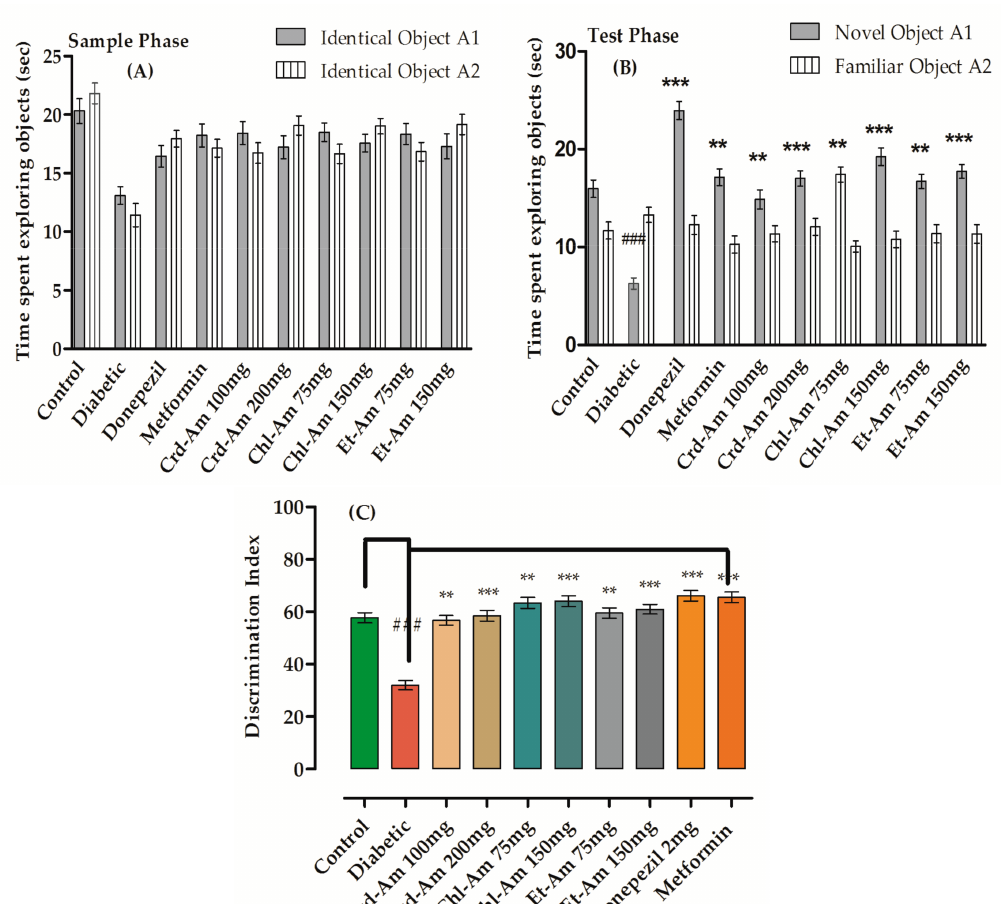
Figure 2. Behavioral results from novel object recognition test (NORT) in long-term memory on crude extract and its fractions of A. macrocephala . Time spent in sample phase is ( A ) and time in test phase is ( B ), while index of % discrimination is ( C ) is noted for crude extract (200 and 100 mg/kg) and fraction (150 and 75 mg/kg)-treated groups versus the STZ-treated diabetic group for the evaluation and recognition of memory in mice models. Mean ± SEM ( n = 6). One-way ANOVA is followed by Dunnett’s post hoc multiple comparison test. ### p < 0.001 comparison of STZ-treated diabetic (amnesic) group vs. normal control, ** p < 0.01 and *** p < 0.001 in comparison with STZ-treated diabetic (amnesic) group vs. Donepezil-, Metformin-, crude extract- and fraction-treated groups, using one-way ANOVA followed by Dunnett’s comparison. Crude extract (Crd-Am), hexane (nhex-Am), chloroform (Chl-Am), ethyl acetate (Et-Am), butanol (But-Am) and aqueous (Aq-Am)